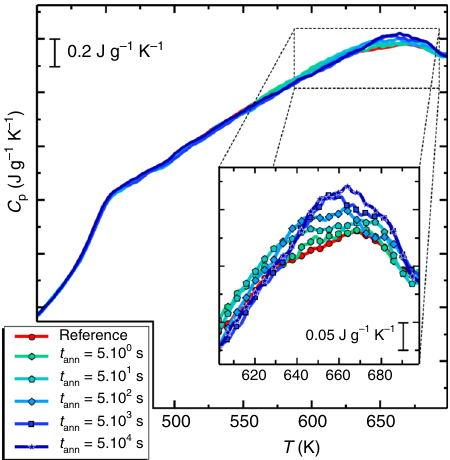
Fig. 4 Evolution of the enthalpy of desorption with annealing time. The heat of desorption increases with annealing time, faster kinetics are observed at higher temperatures (448 K blue down-pointed triangles, 458 K cyan circles, 468 K green up-pointed triangles). Vertical arrows indicate the values of τ eq , the timescale to reach a plateau in the enthalpy of desorption, at each temperature. Error bars account for the uncertainty in the determination of the intensity of the overshoot. In the inset, red stars indicate the values of τ eq , whereas the red line is obtained from the temperature dependence of the segmental mobility, taken from ref. 24 . Error bars account for the uncertainty in the determination of the time necessary to reach a constant Δ H des value in the data set shown in the main panel of the same fi gure.